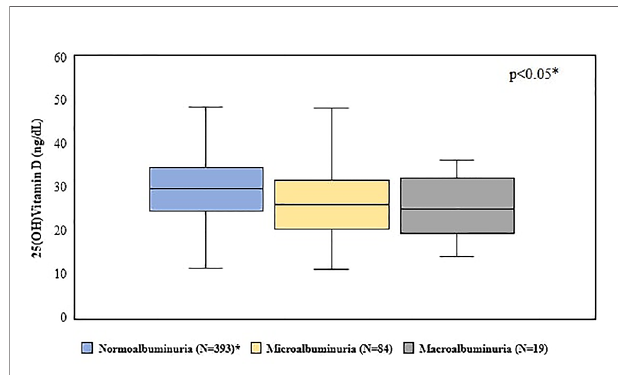
FIGURE 4 | Comparison between vitamin D levels according to albuminuric stages. *p < 0.05 between normoalbuminuria vs microalbuminuria and vs macroalbuminuria. Statistical test used: Kruskal-Wallis test.